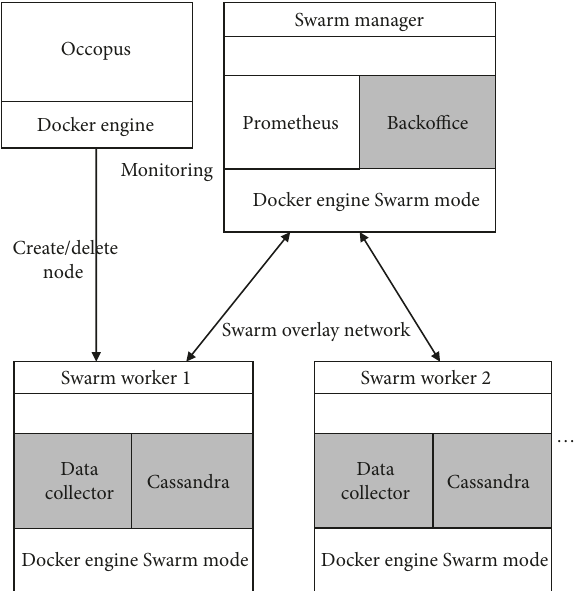
Figure 4: Container-based architecture of the sensor data back-end framework with VM-level